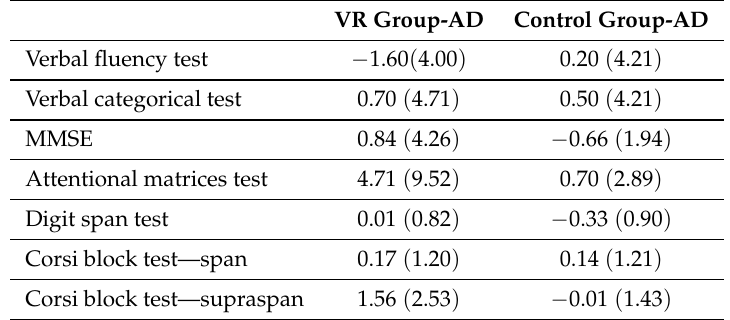
Table 3. One group used VR training and the other (control group) used standard